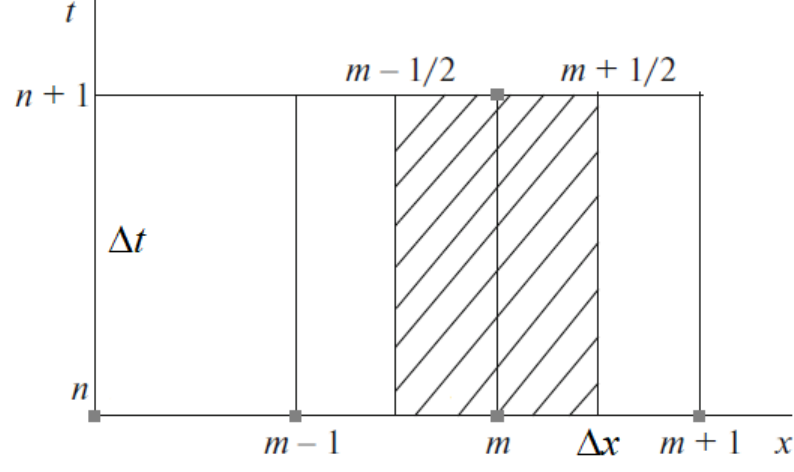
Figure 1. Contour bounding an integration